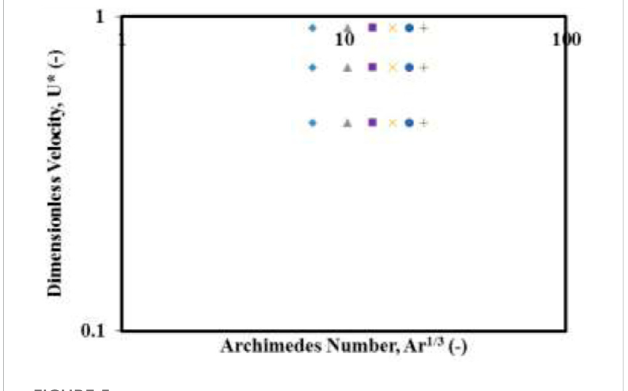
FIGURE 6 Variation of pressure drop as function of gas super fi cial velocity ( U gs )forbedheight=0.235 m.Numbers1and2denoteCFDsimulations for increasing order of particle sizes, respectively, while symbols denote experimental measurements. ■ — 0% large particles; ▲ — 40% large